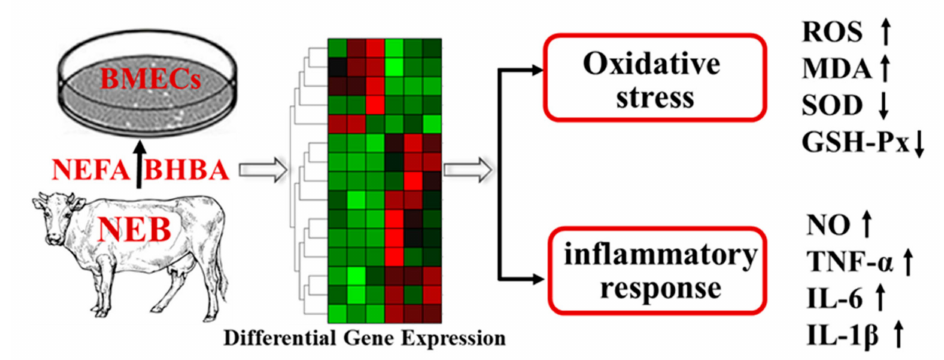
Figure 6. Schematic plot for the toxicity of NEFA and BHBA to BMECs. NEFA and BHBA in- duces oxidative stress (increased MDA and ROS levels, decreased SOD and GSH-Px activities) and inflammatory response (elevated cytokine expression) in